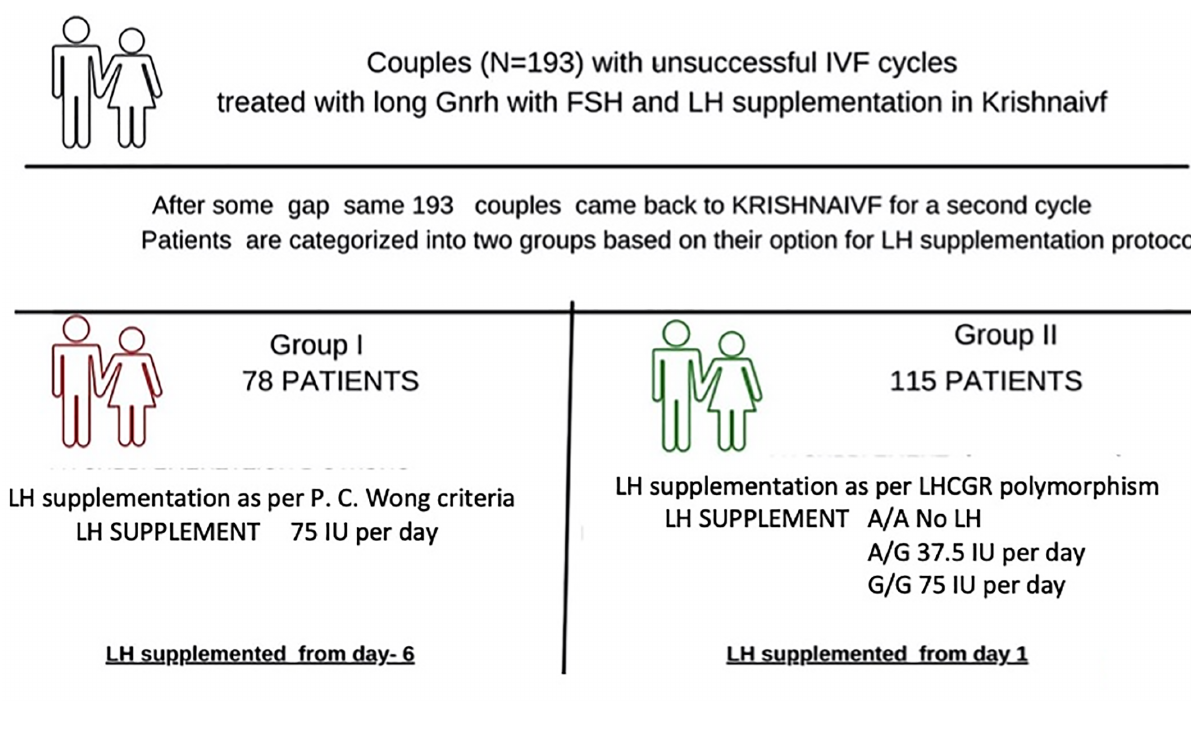
FIGURE 1 | Flow chart for stimulation protocol